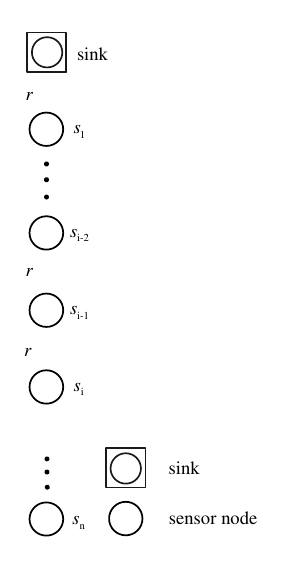
Figure 2. Linear sensor